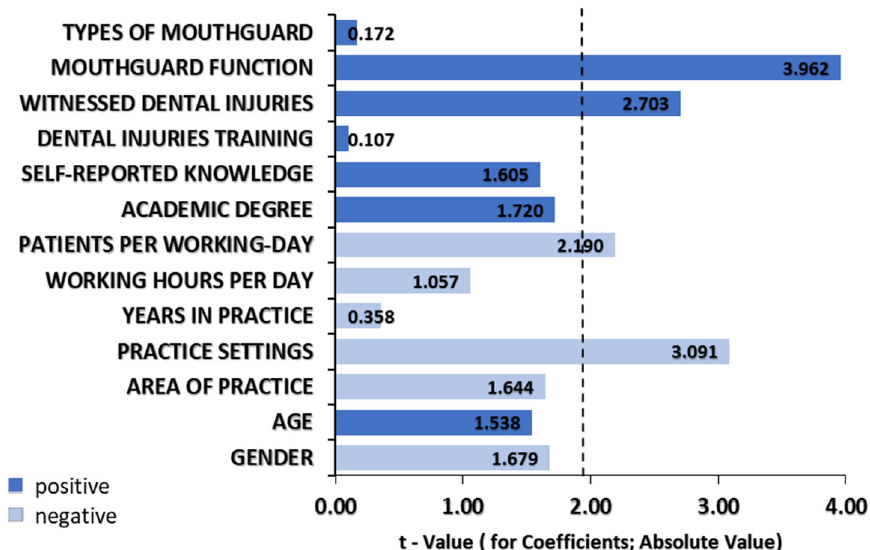
Figure 1. Multiple linear regression analysis. Significant dependence of measured overall dental injuries knowledge score with pediatrician’s demographical data and self-reported knowledge as possible predictors.